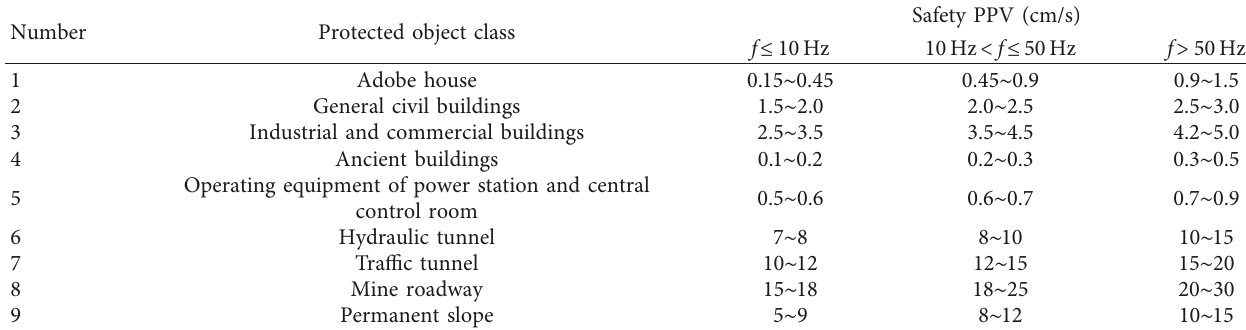
Table 6: Safety standard of blasting